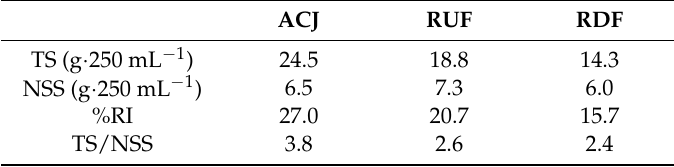
Table 4. Total sugars (TS) and non-sugar soluble solids (NSS) content in a glass (250 mL) of cloudy apple-cranberry juice (ACJ), retentate after ultrafiltration (RUF), and retentate after diafiltration (RDF), together with the percentage of sugars reference intake (%RI) and the ratio of TS to NSS.